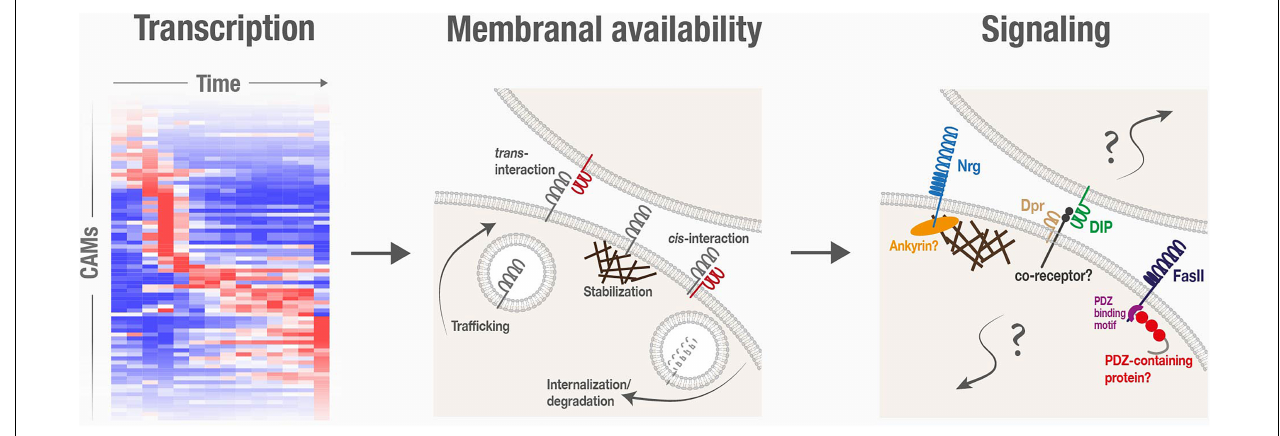
FIGURE 2 | Cell adhesion molecules are spatiotemporally regulated, and are associated with poorly characterized signaling mechanisms, during neuronal